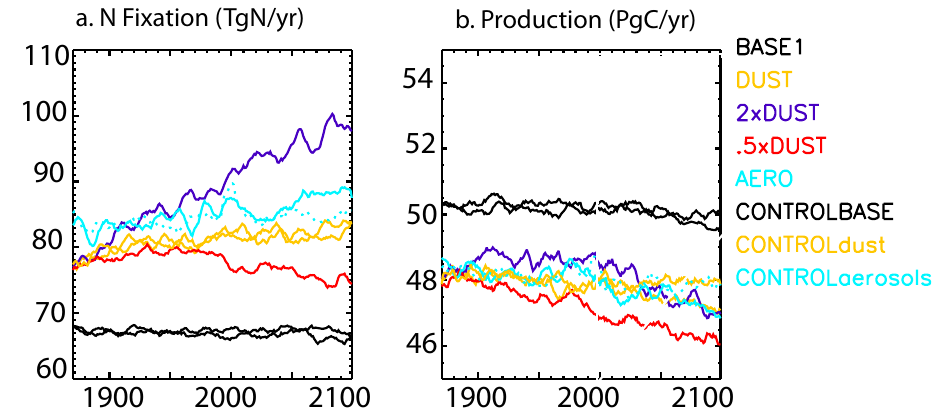
Fig. 5. Time evolution of the globally averaged (a) nitrogen fixation (TgNyear − 1 ) and (b) primary production (PgCyear − 1 ).